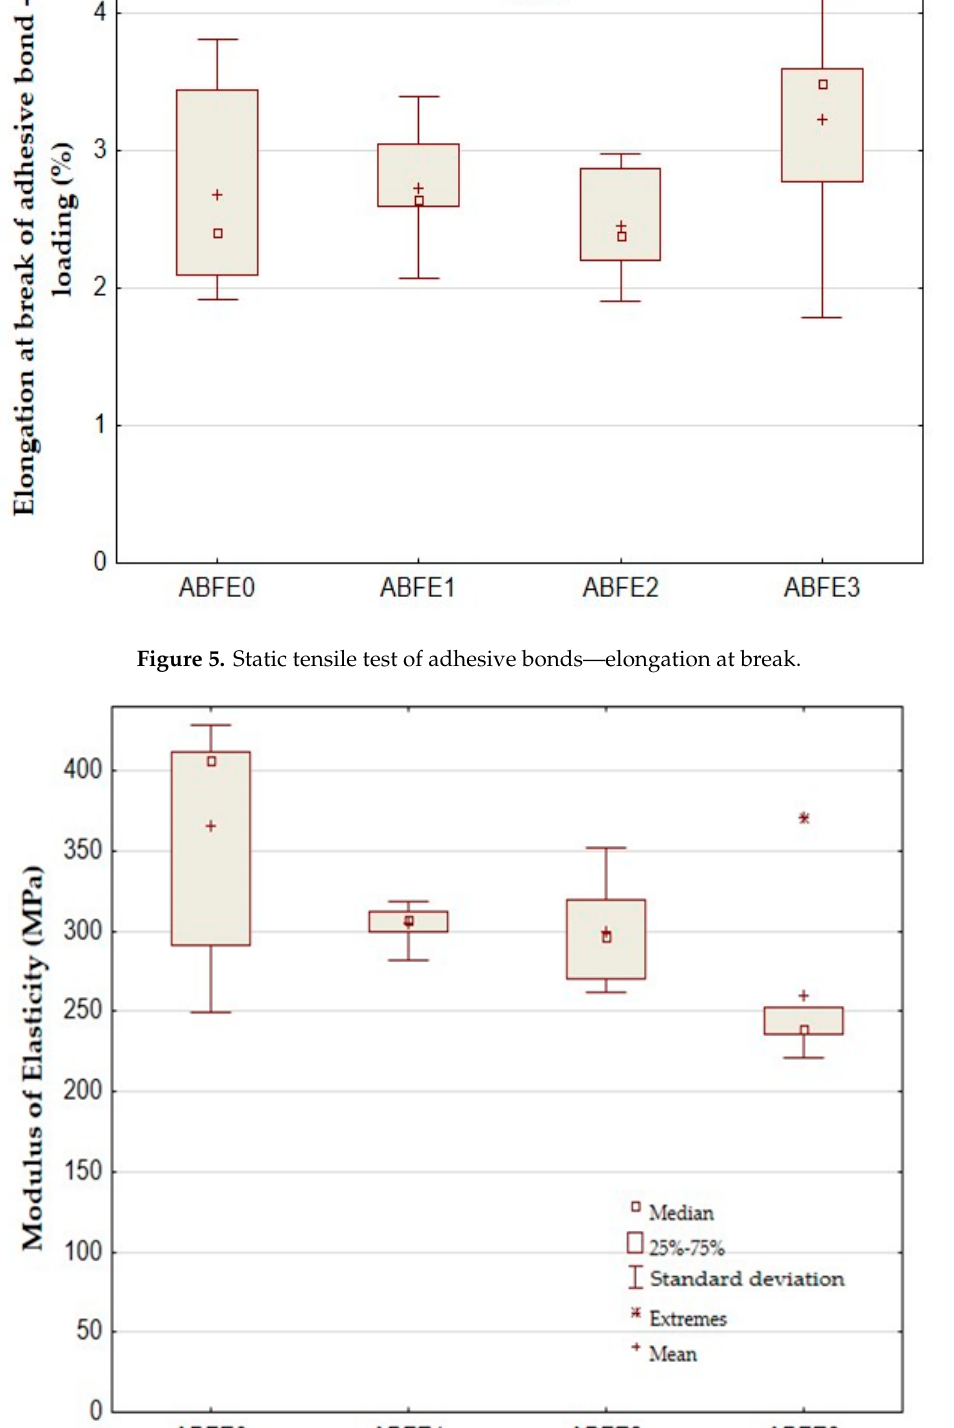
Figure 5. Static tensile test of adhesive bonds—elongation at break.